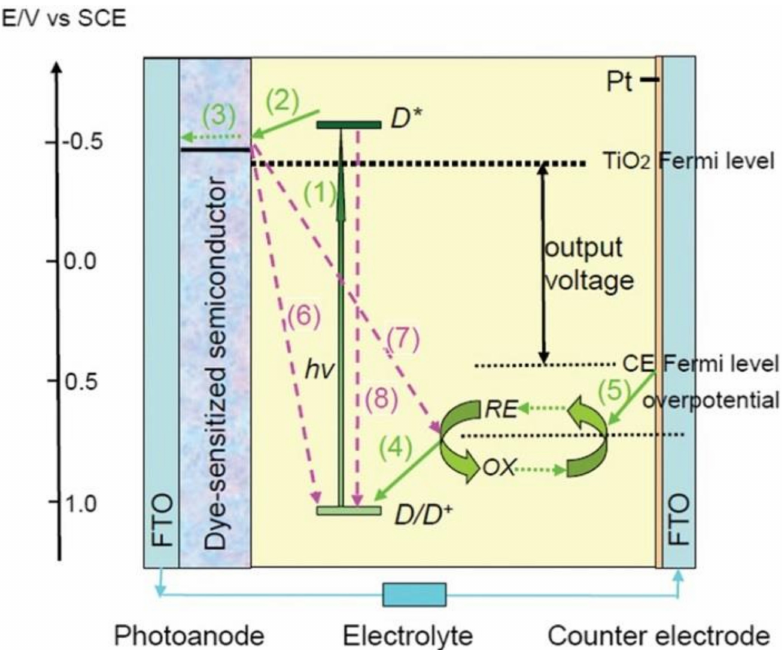
Figure 2. Fundamental processes of dye-sensitized solar cells (Reproduced from Reference [32] with permission, copyright The Royal Society of Chemistry,